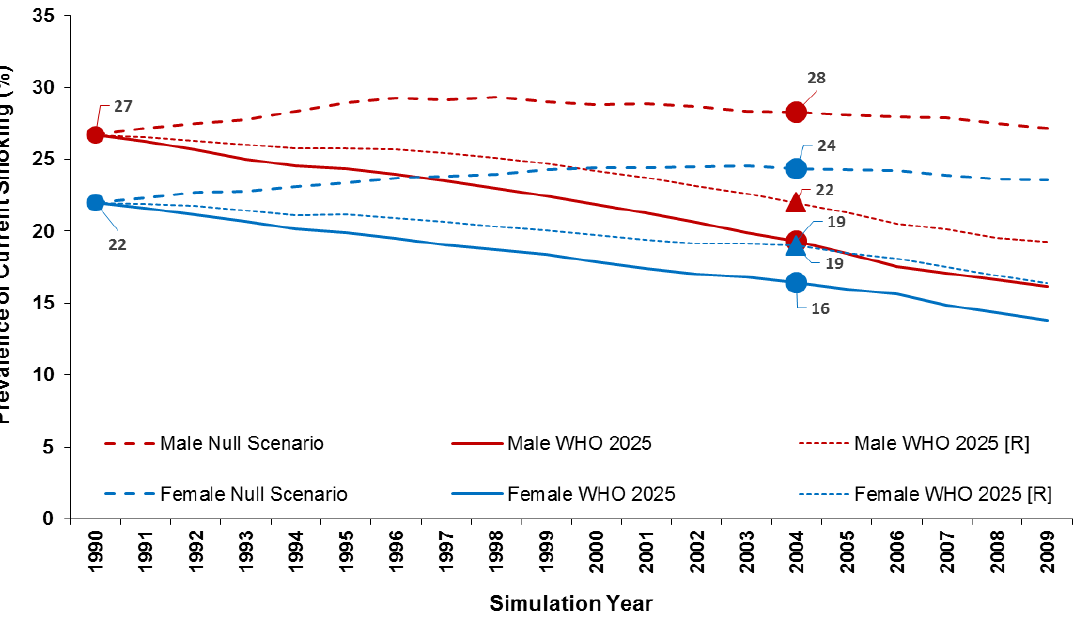
Figure 2. Reduction in smoking prevalence between 1990 and 2005 under the null scenario and the WHO 2025 projections (WHO 2025 reflects the initial estimates of a 30% reduction, WHO 2025 (R) reflects the revised projections).